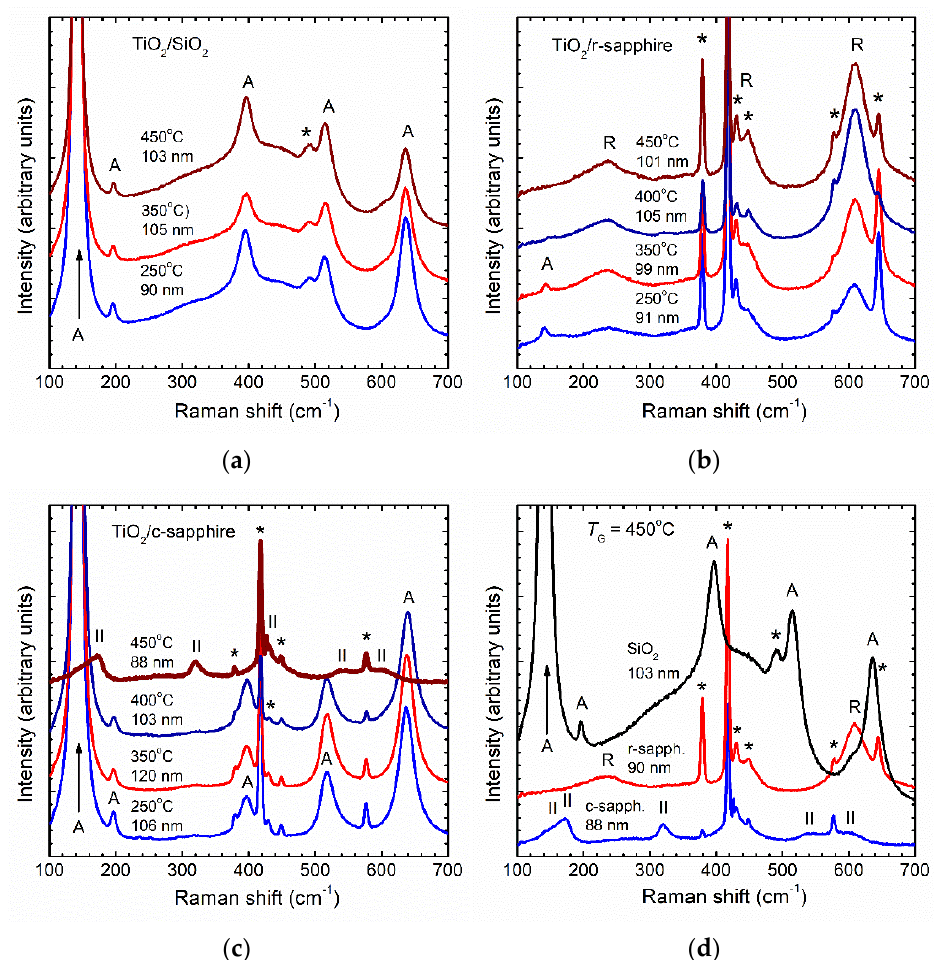
Figure 1. Raman spectra of TiO 2 films grown on ( a ) SiO 2 , ( b ) r-sapphire, and ( c ) c-sapphire at different temperatures and ( d ) on different substrates at 450 °C. Film thicknesses, measured by XRR, and ( a – c ) growth temperatures and ( d ) substrates are shown at respective spectra. Raman bands of anatase (A), rutile (R), TiO 2 -II (II), and substrates (*) are marked.